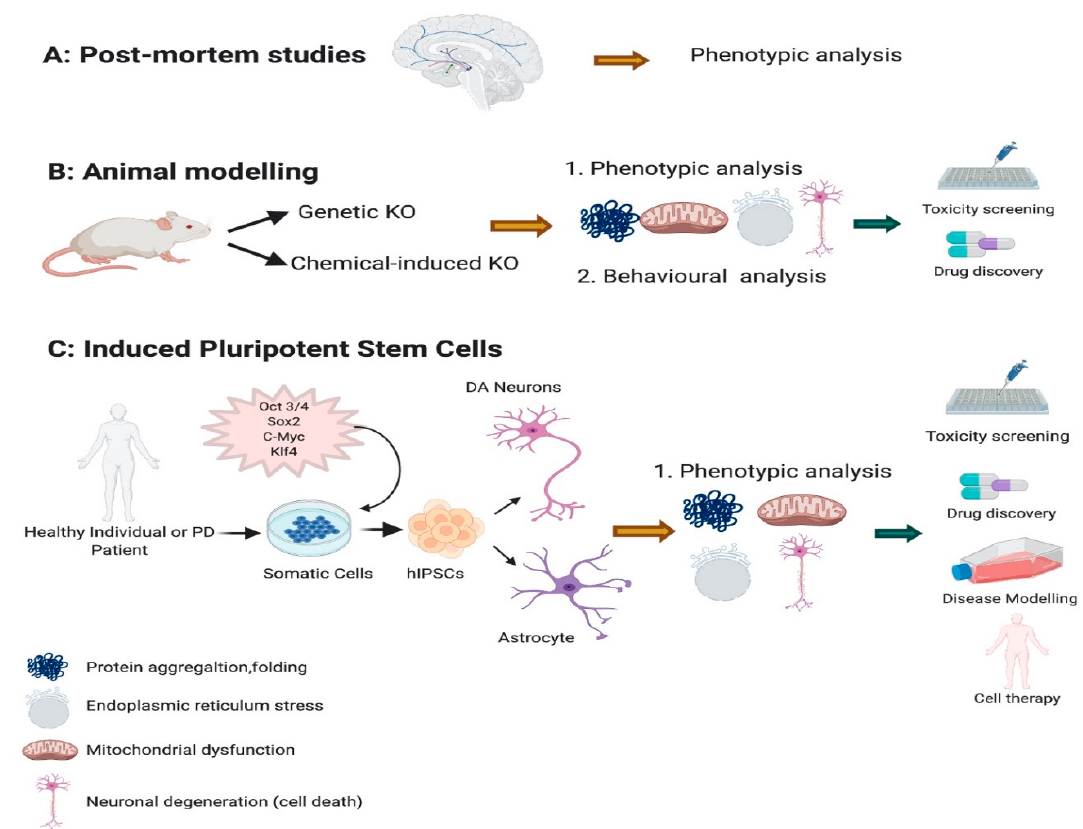
Figure 1. Parkinson's disease (PD) modelling. PD have been modelled and studied using post-mortem ( A ) tissues derived from PD. ( B ) Animal models have been vastly used both by knocking down specific gene or with use of chemicals. This help researchers to investigate the associated phenotypes such as mitochondrial dysfunction, neuronal degeneration and protein folding and aggregation for creating an efficient animal model and use in drug discovery and toxicity. ( C ) Novel induced pluripotent stem cells have been derived from somatic cells of a PD or a healthy individual, leading to generate a disease model in a dish where different phenotypes can be investigated and pave the way towards drug discovery, toxicity testing and cell therapy interventions.